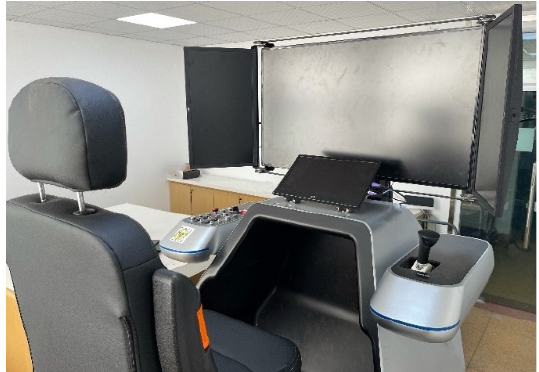
Figure 3. Diagram of the operating platform.